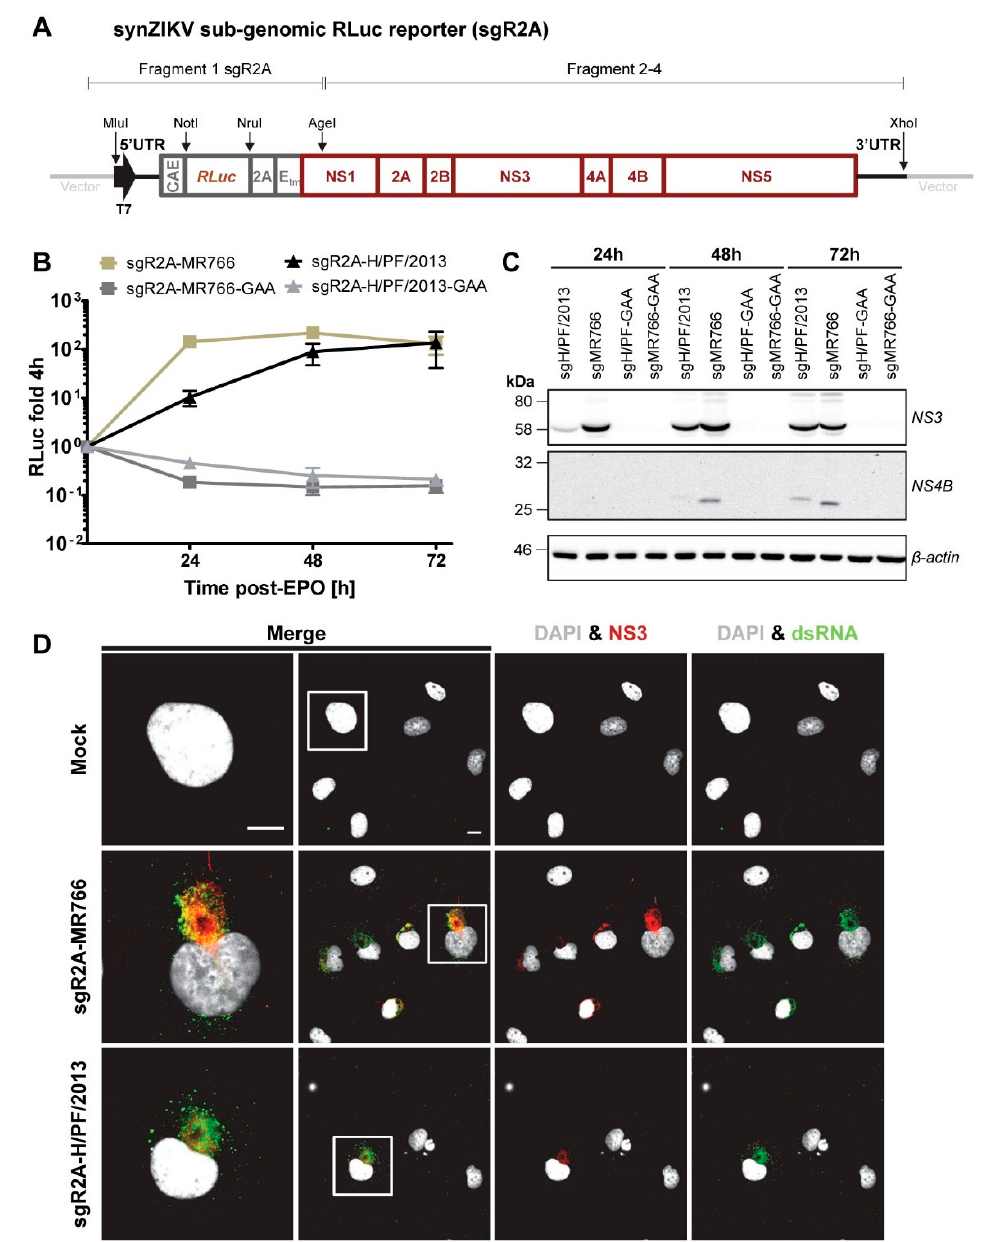
Figure 5. Properties of synZIKV sub-genomic reporter replicons. ( A ) Schematic representation of the synZIKV-sgR2A subgenomic reporter replicons. The reporter cassette (grey) was inserted into the synZIKV genomes via the MLuI and AgeI restriction sites and replaces the region encoding the structural proteins. ( B ) RLuc activity in Huh7 cells transfected with wild-type or replication-deficient (mutant GAA) synZIKV-sgR2A replicon RNAs measured at given times post-transfection. Shown RLuc values were normalized to the 4 h value to correct for transfection efficiency. Mean ± SEM of three independent experiments is presented. ( C ) Western blot showing the abundance of ZIKV NS3 and NS4B proteins in Huh7 cells transfected with synZIKV-sgR2A replicon RNAs. Cells were lysed at indicated times post-transfection and ZIKV-specific antibodies were used to detect viral proteins. β actin served as loading control. Numbers on the left refer to the positions of marker proteins that are given in kilodalton (kDa). ( D ) Immunofluorescence analysis of Huh7 cells 48 h post-transfection of synZIKV-sgR2A RNAs. Cells were stained with a dsRNA- (green) and a NS3-specific antibody (red). Nuclear DNA was stained with DAPI (grey). Scale bars = 15 µ m. Boxed areas indicate regions that are shown in the left panels as enlargements.